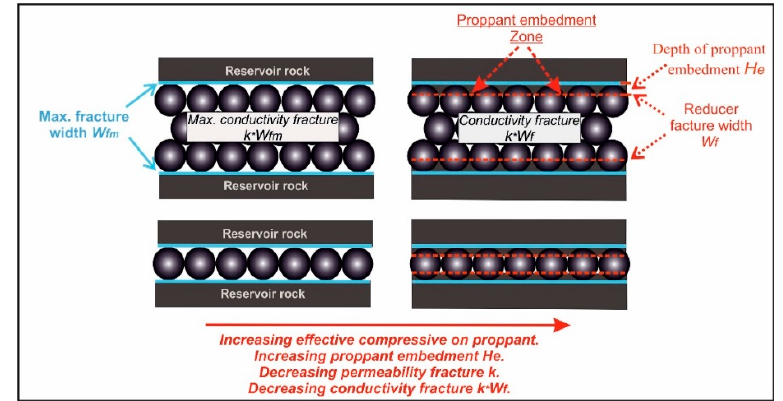
Figure 3. The effect of the embedment phenomenon on the width of a packed fracture for various Figure 3. The e ff ect of the embedment phenomenon on the width of a packed fracture for various proppant surface concentration. proppant surface